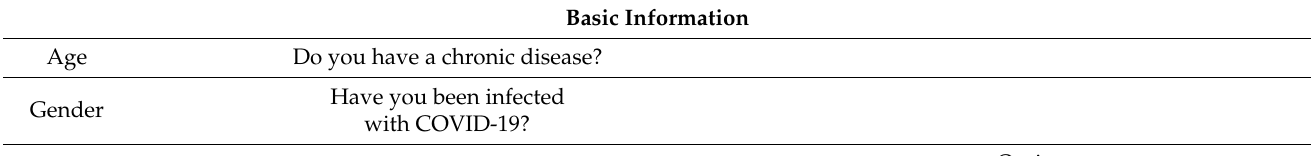
Table 2. The questionnaire.